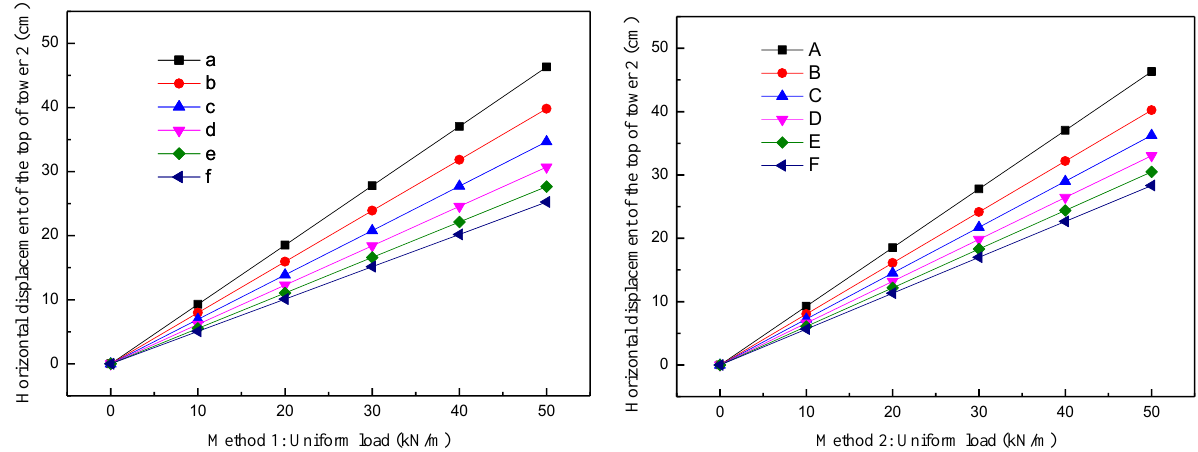
Figure 4. Comparison of horizontal displacement of mid-tower.